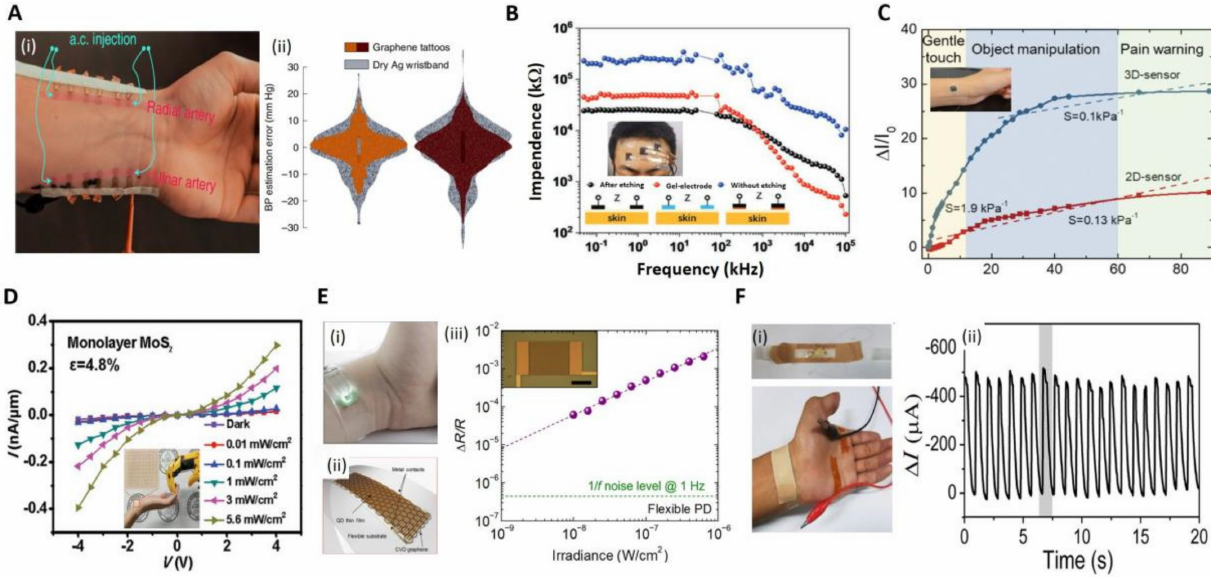
Figure 2. Several e − skins based on 2D materials. ( A ): (i) Photo of the graphene bioimpedance tattoos attached to human skin. (ii) Comparison of statistical violin plots of graphene Z − BP versus commercial dry silver wristbands (diastolic (left) and systolic (right)) [97]. Copyright 2022, Springer Nature. ( B ): Impedance difference between LSG/PU e − skin with and without etched PU and commercial gel electrodes during measurement (the illustration shows the optical image when worn on the user’s head) [98]. Copyright 2022, Wiley-VCH. ( C ): Relative current change versus applied pressure for the pressure sensors based on 3D microelectrodes and 2D flat electrodes, where S represents the sensitivity of the pressure sensor; inset shows a photo of the sensor attached to the skin [86]. Copyright 2019, Wiley − VCH. ( D ): Current versus source − drain voltage on a single layer of MoS 2 ; illustration of this elastomeric substrate attached to a human wrist for lighting detection and human–machine interaction [90]. Copyright 2022, Wiley-VCH. ( E ): (i) Physical diagram of reflection mode photodetector. (ii) Schematic illustration of the assembly of graphene and QDs on a flexible substrate. (iii) Photo-induced resistance change ( ∆ R/R) with respect to irradiance at 633 nm. [87]. Copyright 2019, American Association for the Advancement of Science. ( F ): (i) Photograph of the measurement for wrist pulses. (ii) 20 s real-time record of wrist pulses [91]. Copyright 2017, American Chemical